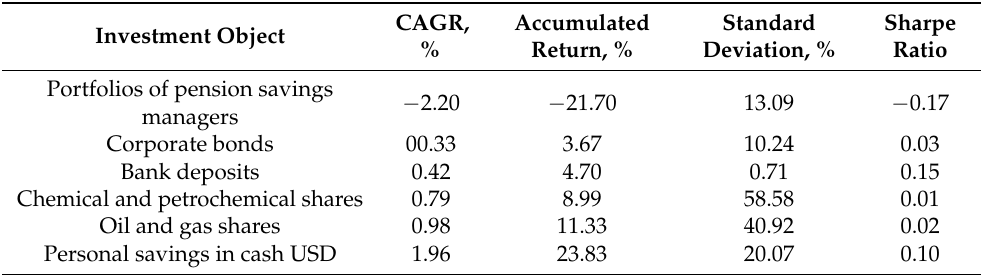
Table 2. The real efficiency of investment activity of pension savings managers in comparison with investment alternatives for